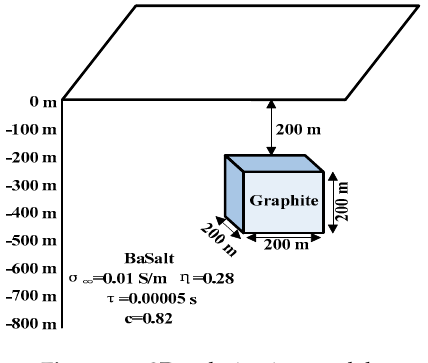
Figure 17. Porous polarized media depth imaging (( a ) traditional skin depth formula; ( b ) generalized polarized media skin depth formula).